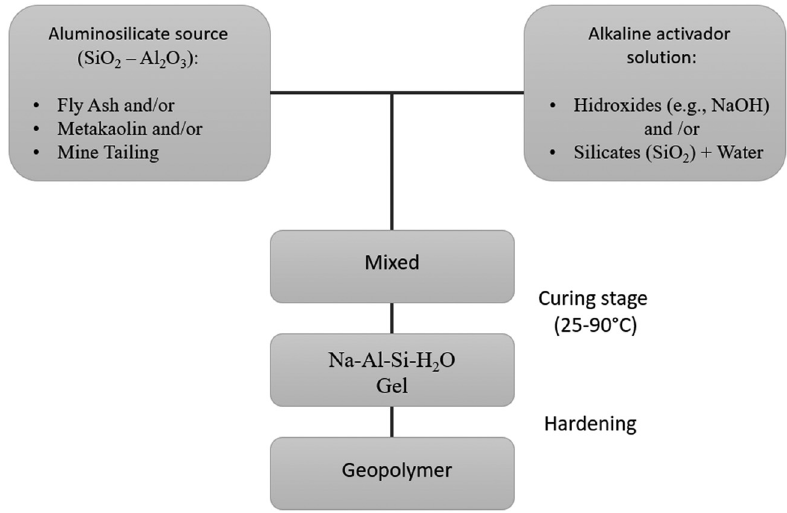
Figure 1: Diagram of the process of creating a